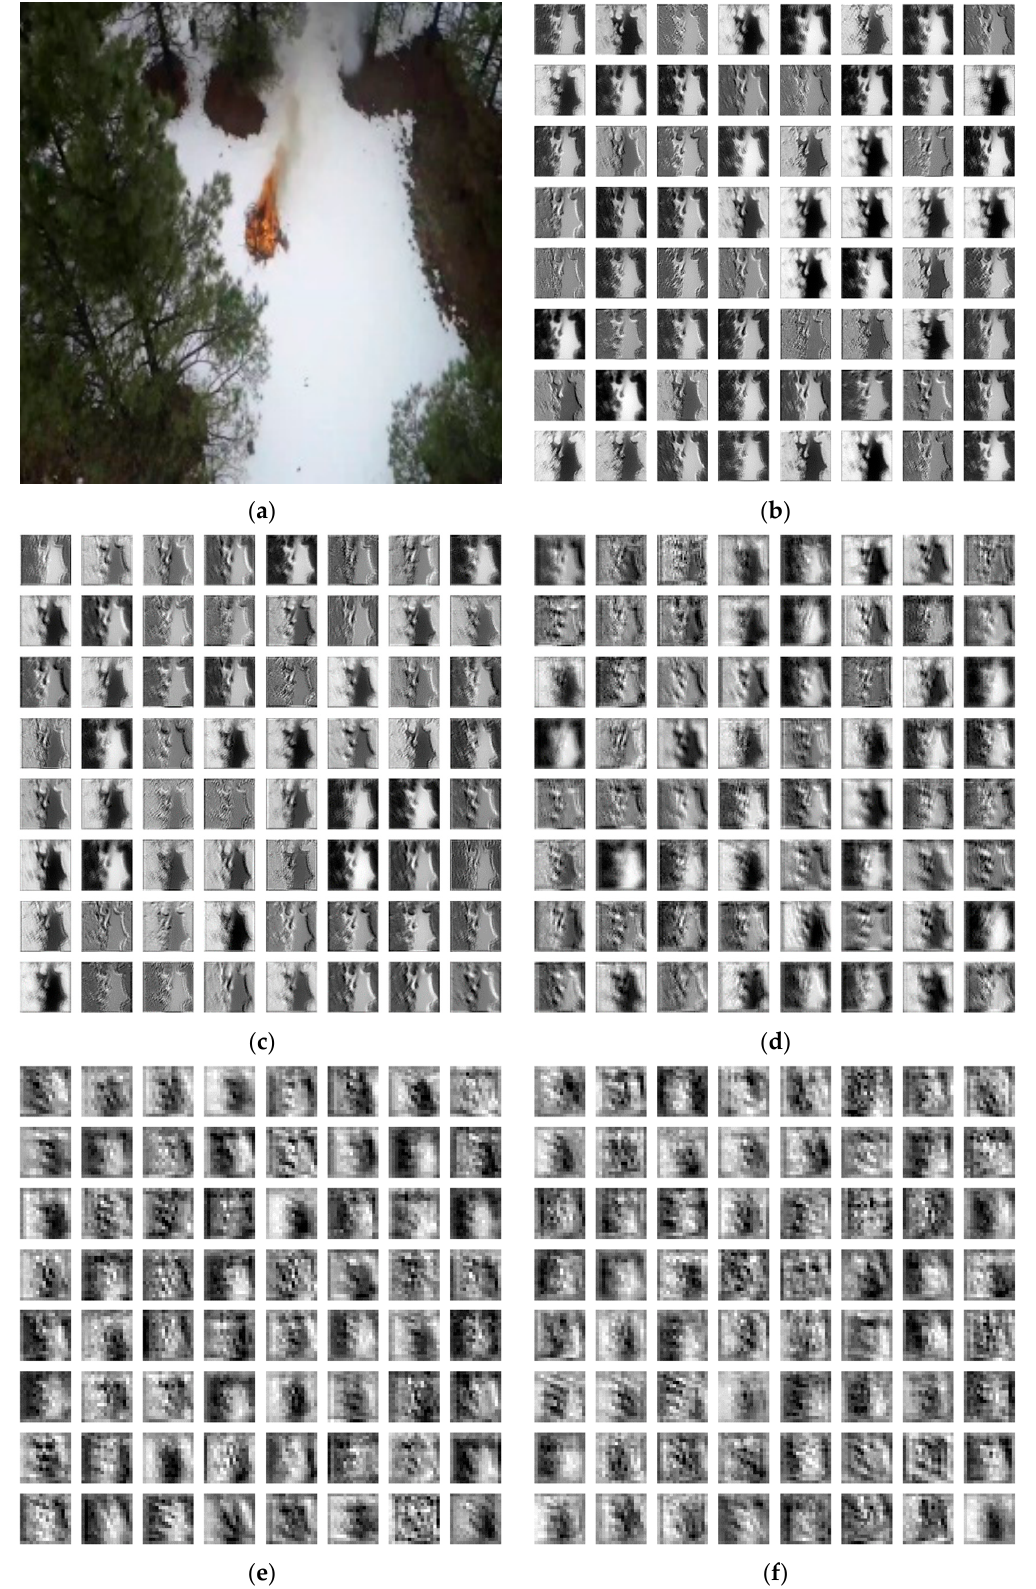
Figure 13. Feature visualization results: ( a ) resized_frame0; ( b ) ConvBlock1; ( c ) ConvBlock2; ( d ) ConvBlock3; ( e ) ConvBlock4; ( f ) ConvBlock5.